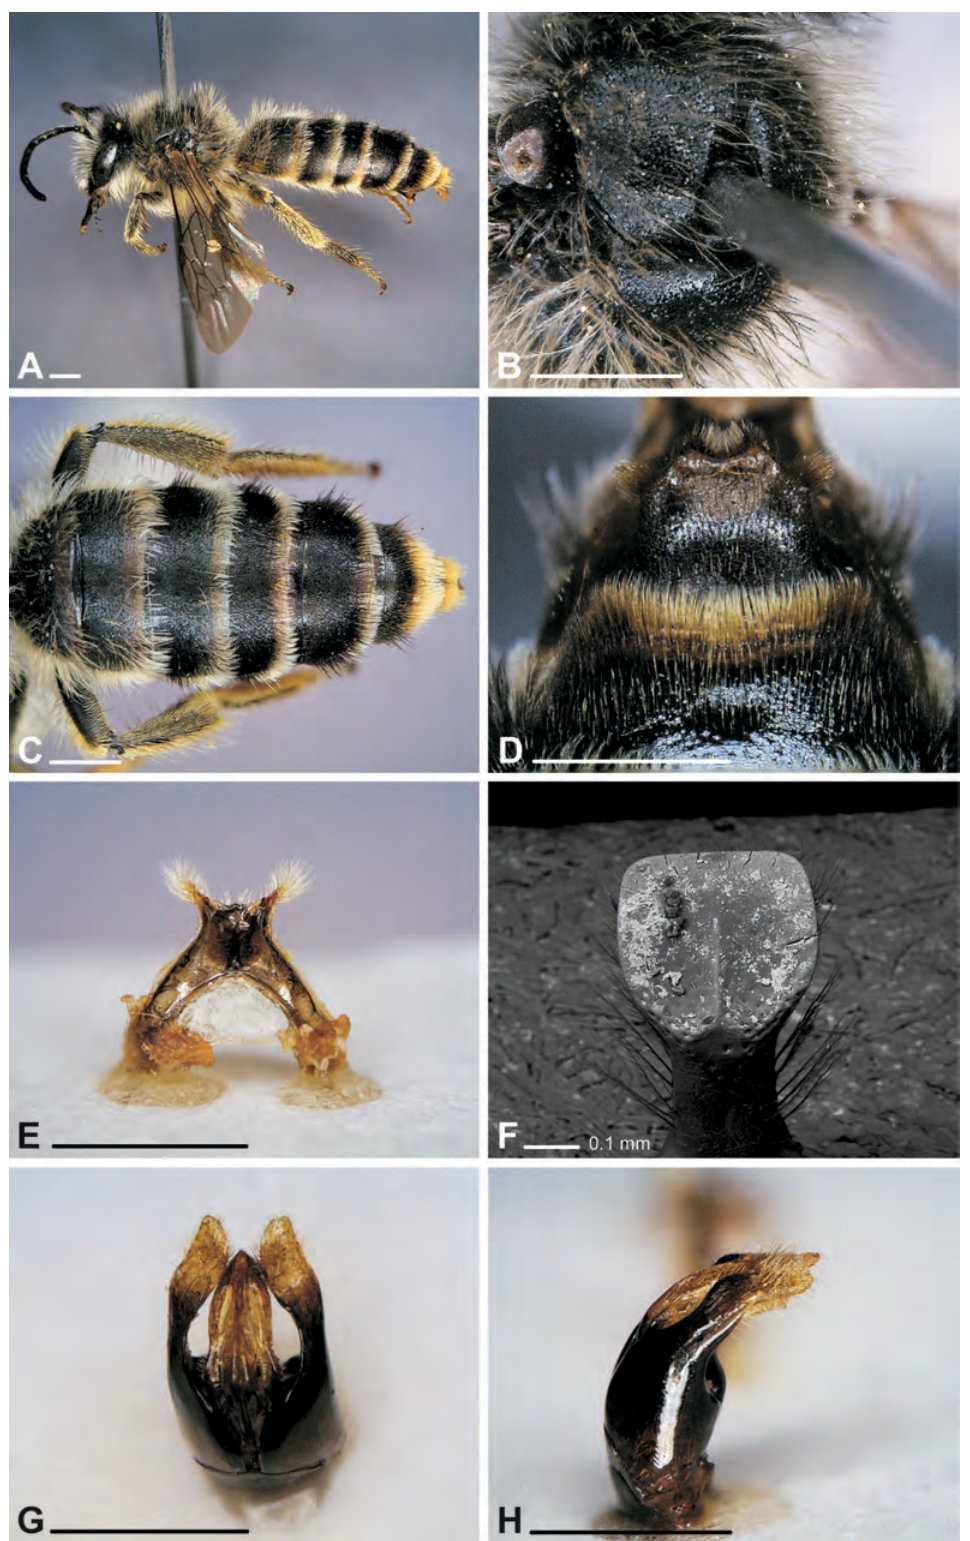
Fig. 11. Redivivoides namaquaensis sp. nov., ♂. A . lateral view. B . Scutum and scutellum. C . Metasoma (dorsal view). D . S6 (ventral view). E . S7 (dorsal view). F . S8, apical end (backscattered electron image). G . Genitalia (dorsal view). H . Genitalia (lateral view). Scale bar: 1